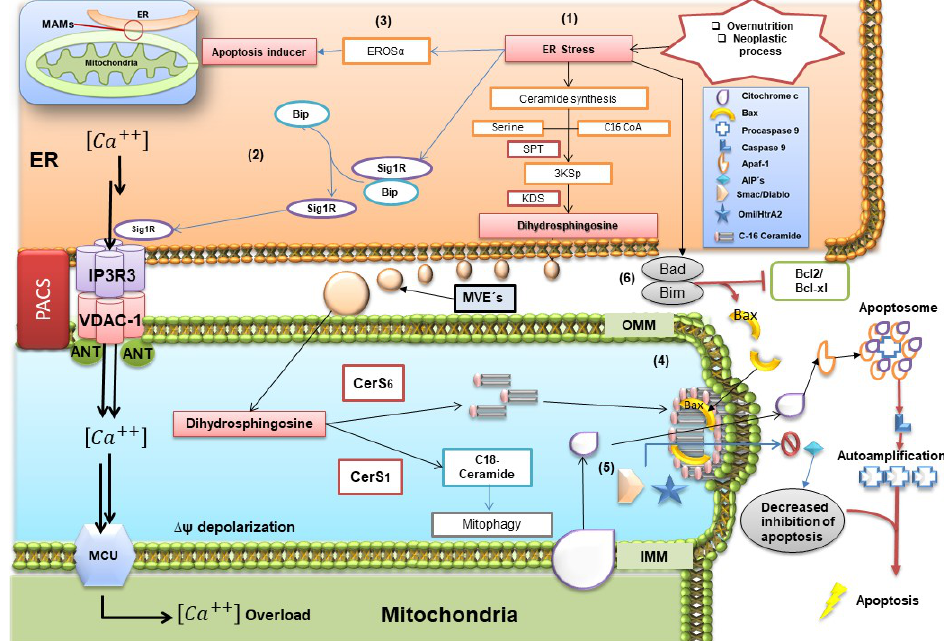
Figure 2. Overview of endoplasmic reticulum (ER) and mitochondria interactions. ER stress phenomenon promotes the activation of the de novo ceramide pathway, producing an increase in the exportation of dyhidrosphingosine and enzymes such as CerS1 and CerS6 through mitochondria-associated ER membranes (MAMs) or multivesicular endosomes (MEVs) to mitochondria (1), this originates the cleavage of Sig1R/Bip complex, Sig1R binds to IP3R3/VDCA-1 allowing the flow of Ca 2+ through the ER to the inter-membranal space of the mitochondria by MCU (2), it can cross the inner mitochondrial membrane, producing a supersaturation in the mitochondrial matrix. This condition facilitates the activation of apoptosis by means of CHOP-dependent EROSα (3). In inter-membrane space, C16 ceramide leads to synthesis and assembly of pores that synergistically with Bax are translocated to OMM (4), this modifies the permeability of the membrane and allows the output of cytochrome C and proteins as SMAC/DIABLO and Omi/Htra (5). Later, cytochrome-C is associated with Apaf-1, promoting the change from procaspase-9 to caspase-9, leading to apoptosome formation. The complex Bad/Bim inhibits the antiapoptotic action of Bcl-2 and Bcl-xL, which in turn are associated with preventing the oligomerization of Bax with the pores, as well as inhibition of cytochrome C release (6). Image adapted from references: [4,14,18,37–39].